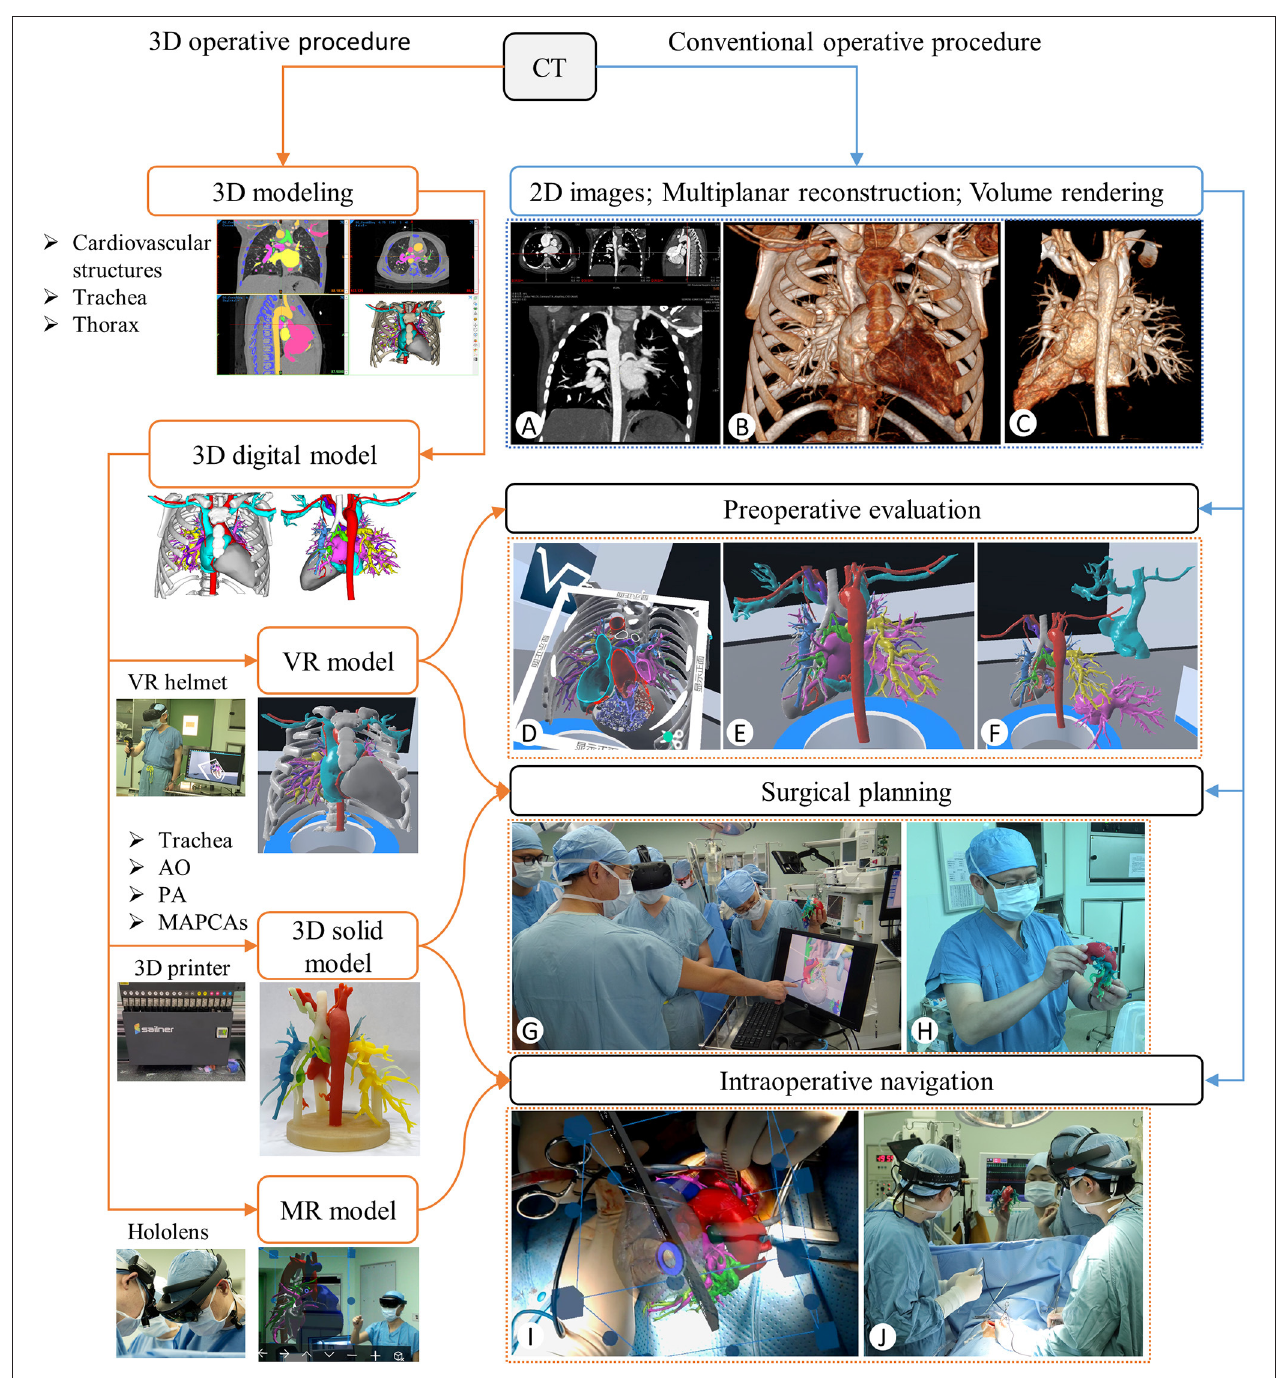
FIGURE 1 | Flows of the 3D visualized (orange line) and the conventional (blue line) operative procedures. (A) CT Multiplanar Reconstruction to review the anatomy. (B,C) CT Volume rendering with and without the thorax part. (D–F) Preoperative evaluation with the section, rotation, and separation of the VR models. (G,H) Surgical planning with the VR and 3D solid models. (I,J) Determination of the MAPCAs location by coinciding the virtual and real hearts on the Hololens device (I) and anatomical review by observing the 3D solid model placed next to the operating table (J) during the